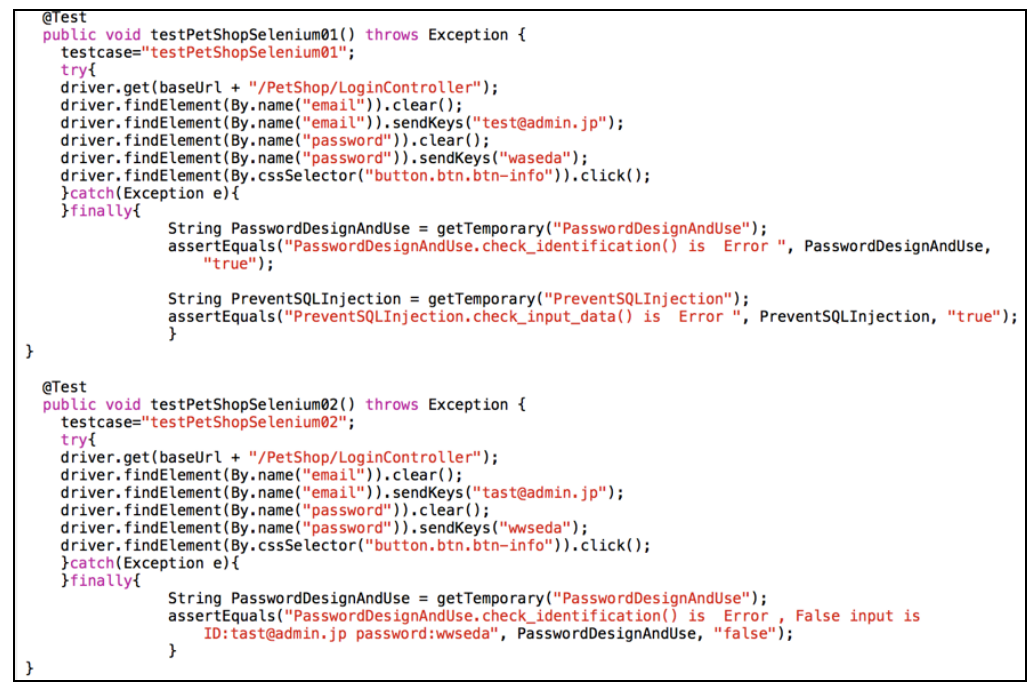
Figure 19. Part of the test case for Student 1 using our method.